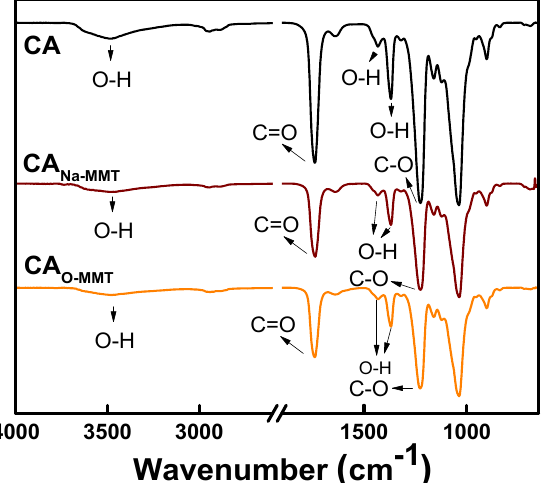
Figure 1. ATR-FTIR spectra of CA, CA Na-MMT , and CA O-MMT . Table 1. Surface elemental composition of the membranes using XPS analysis.